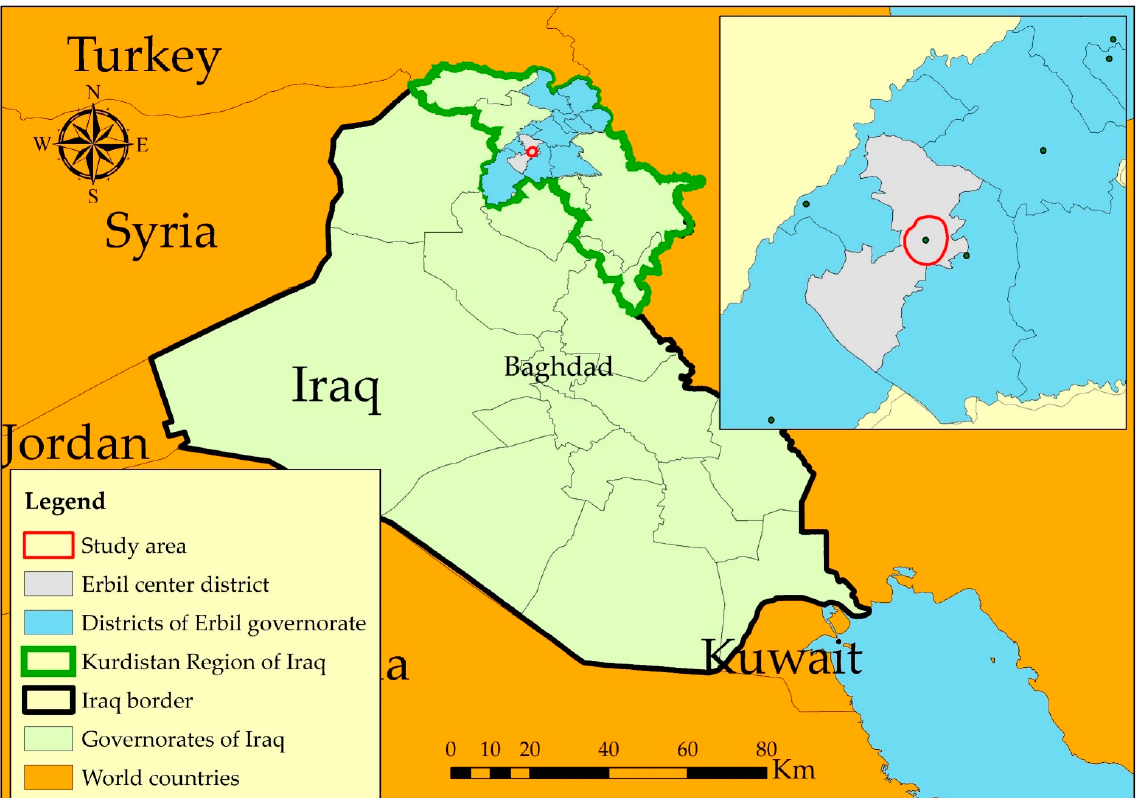
Figure 1. Study area.